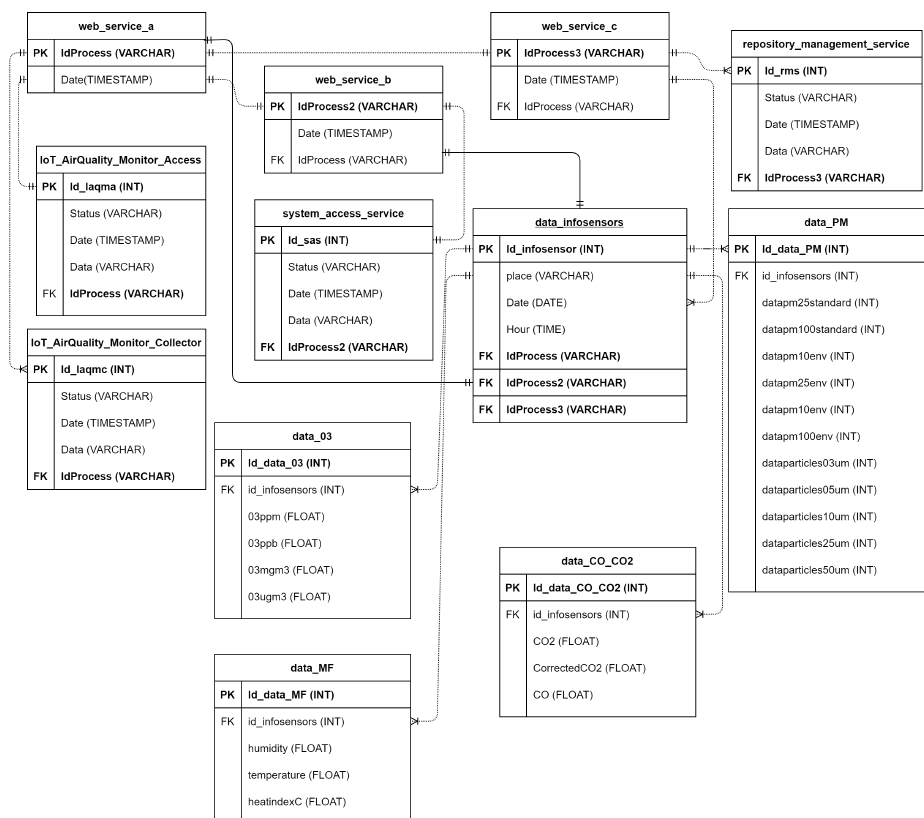
Figure 2. The entity-relationship diagram of the IoT air quality information system